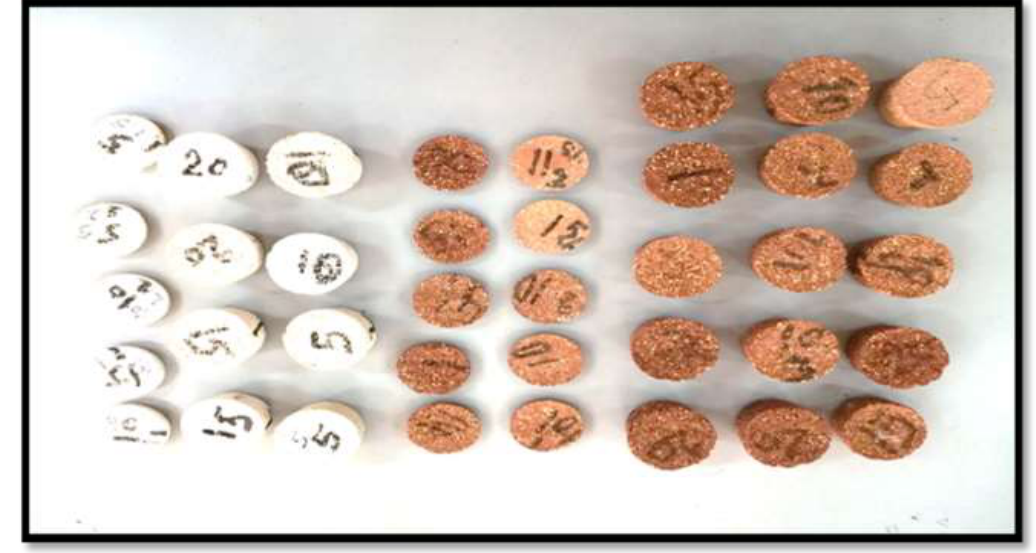
Figure 1: Specimen after firing at 1200 ℃